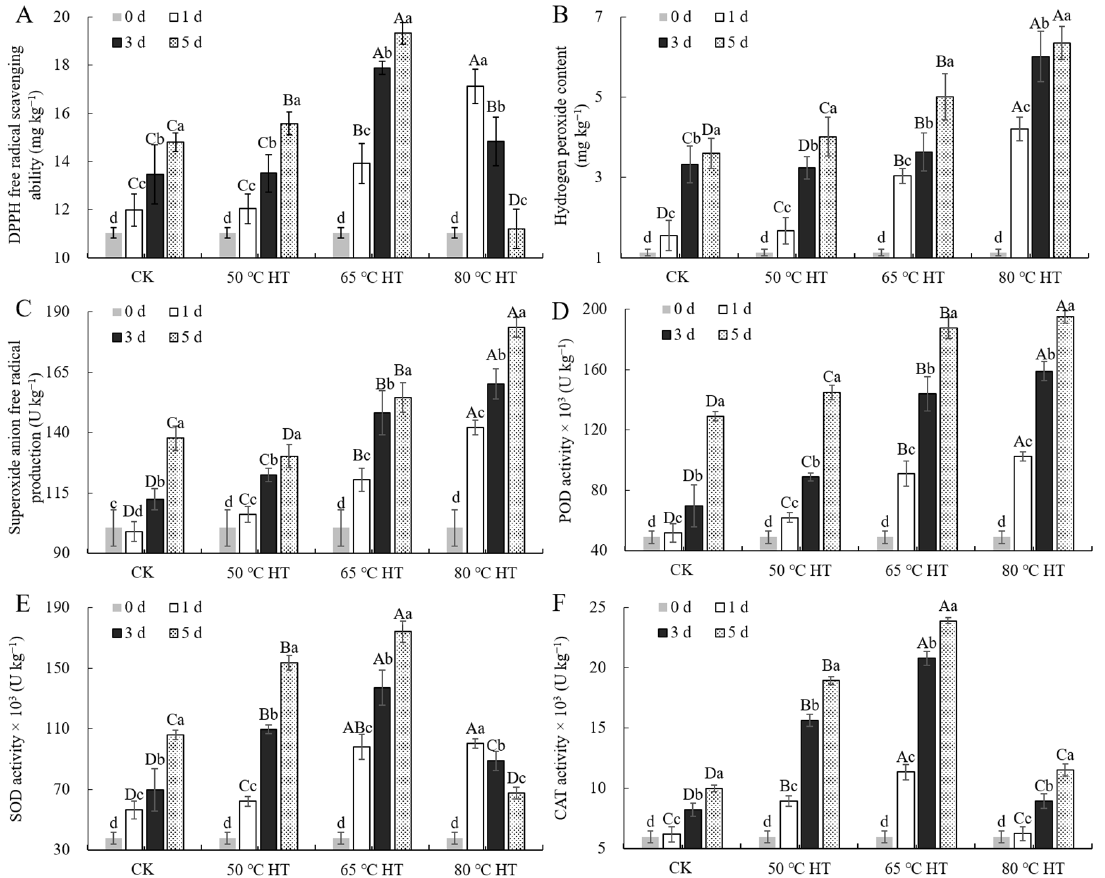
Figure 5. Effects of RHT treatment on DPPH, hydrogen peroxide, and superoxide anion scavenging and POD, SOD, and CAT activity in sweet potato callus (( A ): DPPH free radical scavenging ability; ( B ): Hydrogen peroxide content; ( C ): Superoxide anion free radical production; ( D ): POD activity; ( E ): SOD activity; ( F ): CAT activity. Note: Capital letters are comparisons at the same time at different temperatures, and lowercase letters are comparisons at different times at the same temperature).